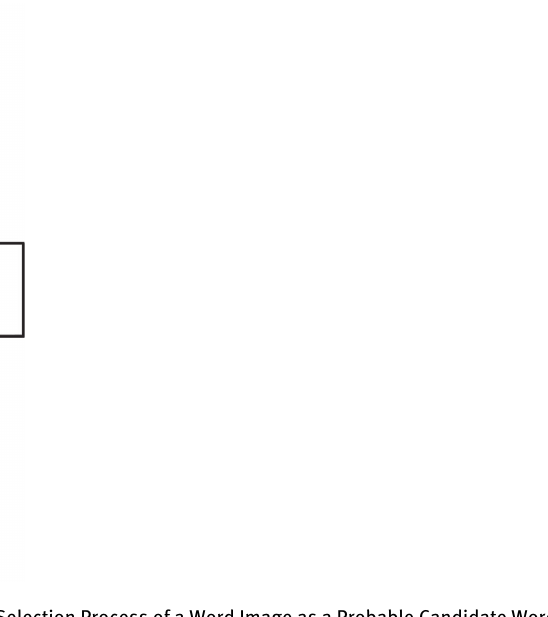
Figure 7: Diagrammatic Representation of the Selection Process of a Word Image as a Probable Candidate Word Using a Rule-Based